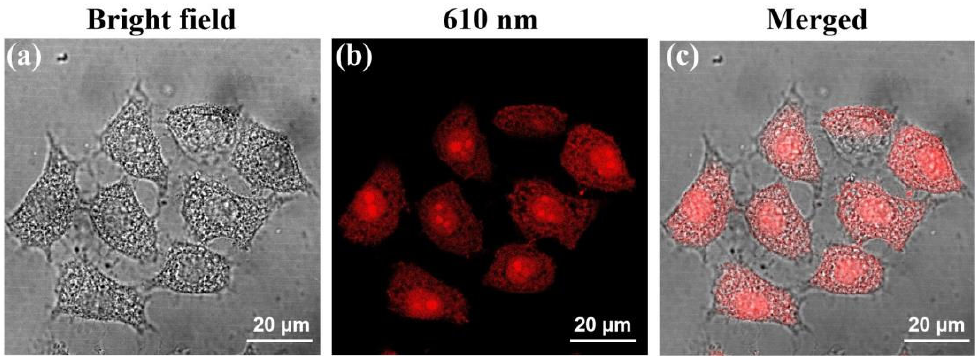
Figure 7. CLSM images of HepG2 incubated with 200 μg mL −1 T − CDs for 2h. The images were obtained under ( a ) bright − field, ( b ) 610 nm excitation and ( c ) merge from left to right (Scale bar = 20 μm).